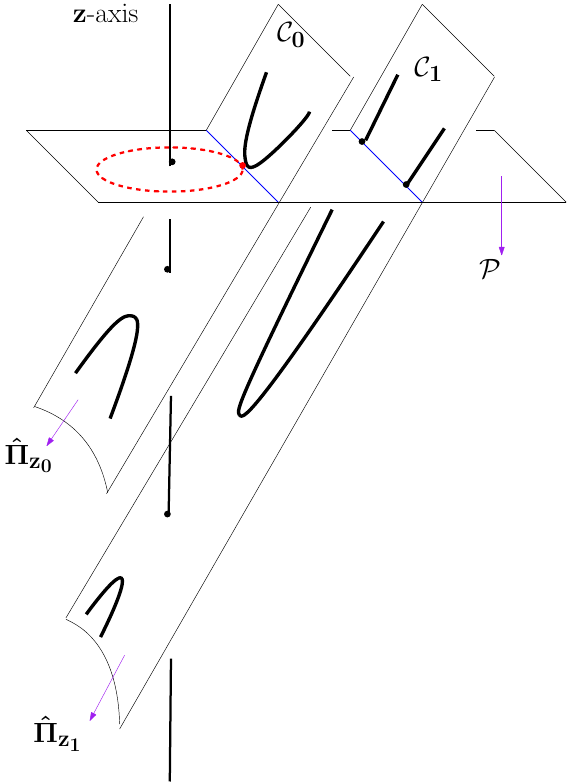
Figure 1. The case of hyperbolic affine rotation surfaces (I).